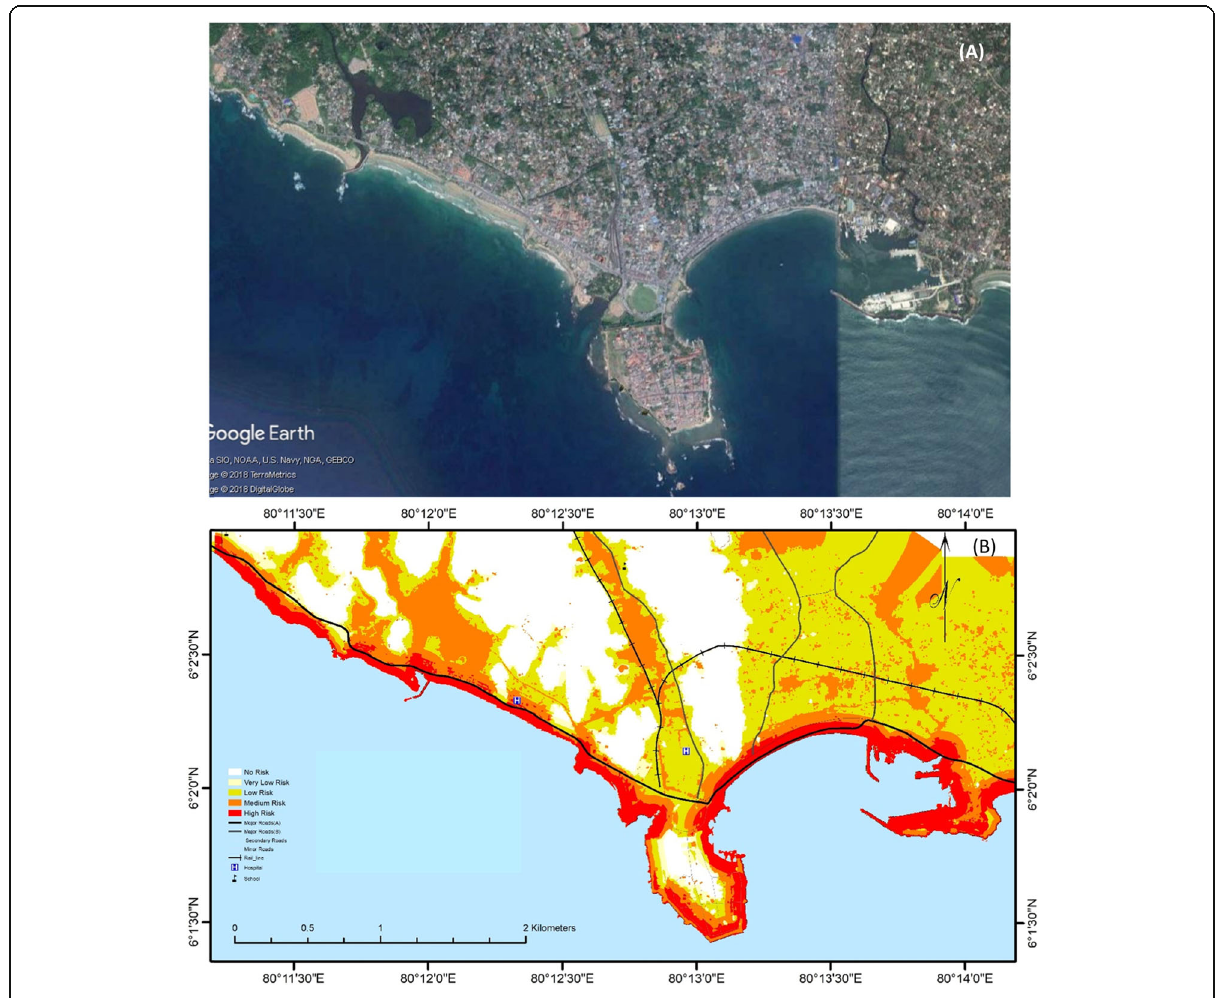
Fig. 6 ( a ) Satellite image of Galle, and ( b ) risk assessment map of the